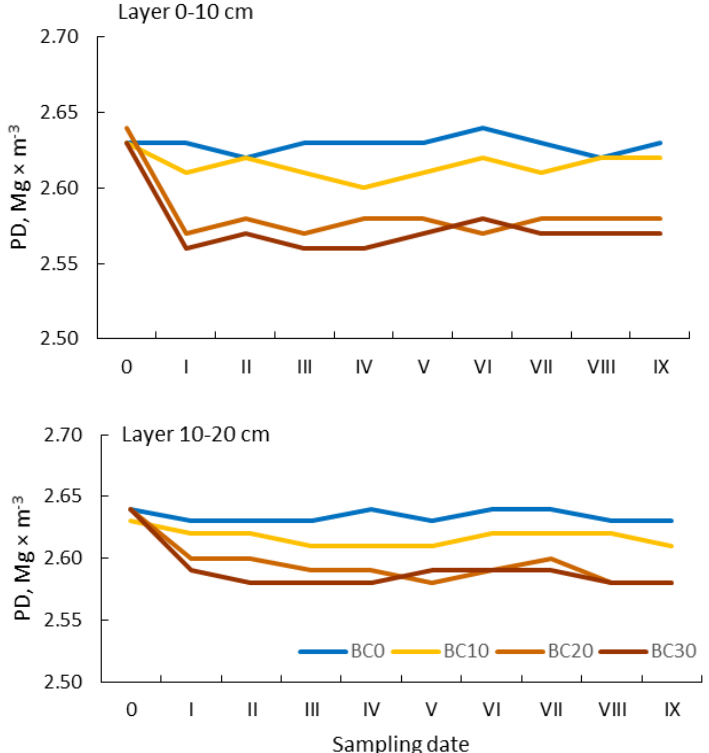
Figure 1. Particle density (PD). Explanations: BC0—control: soil without application biochar; BC10—soil with application biochar in the dose 10 Mg × ha − 1 ; BC20—soil with application biochar in the dose 20 Mg × ha − 1 ; BC30—soil with application biochar in the dose 30 Mg × ha − 1 ; 0, I, III, ... , IX—sampling date (2010–2019).